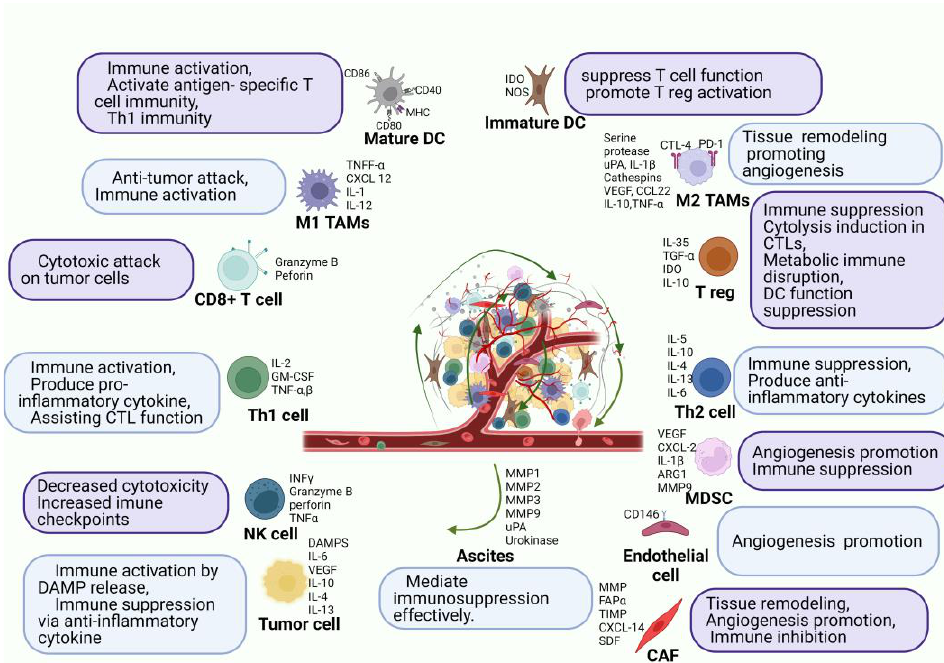
Figure 2. Cells in the ascites tumor microenvironment (TME). The peritoneal carcinomatosis microenvironment is formed of malignant ascites and solid tumor tissue. Under the influence of the ascites, which exchange O2 and nutrients with the circulatory system, cells actively communicate with each other through molecules they produce (cytokines, chemokines, DAMPs, etc.) and receptors they express (MHC, PD-1). The TME may re-polarize the same set of cells or move cell components to other locations. The growth or shrinkage of a tumor site is controlled by a complex network of cells and molecules in the TME.